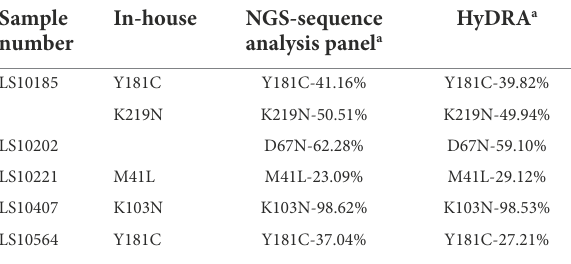
TABLE 1 Comparison of the detection results of the three detection methods. Sample number